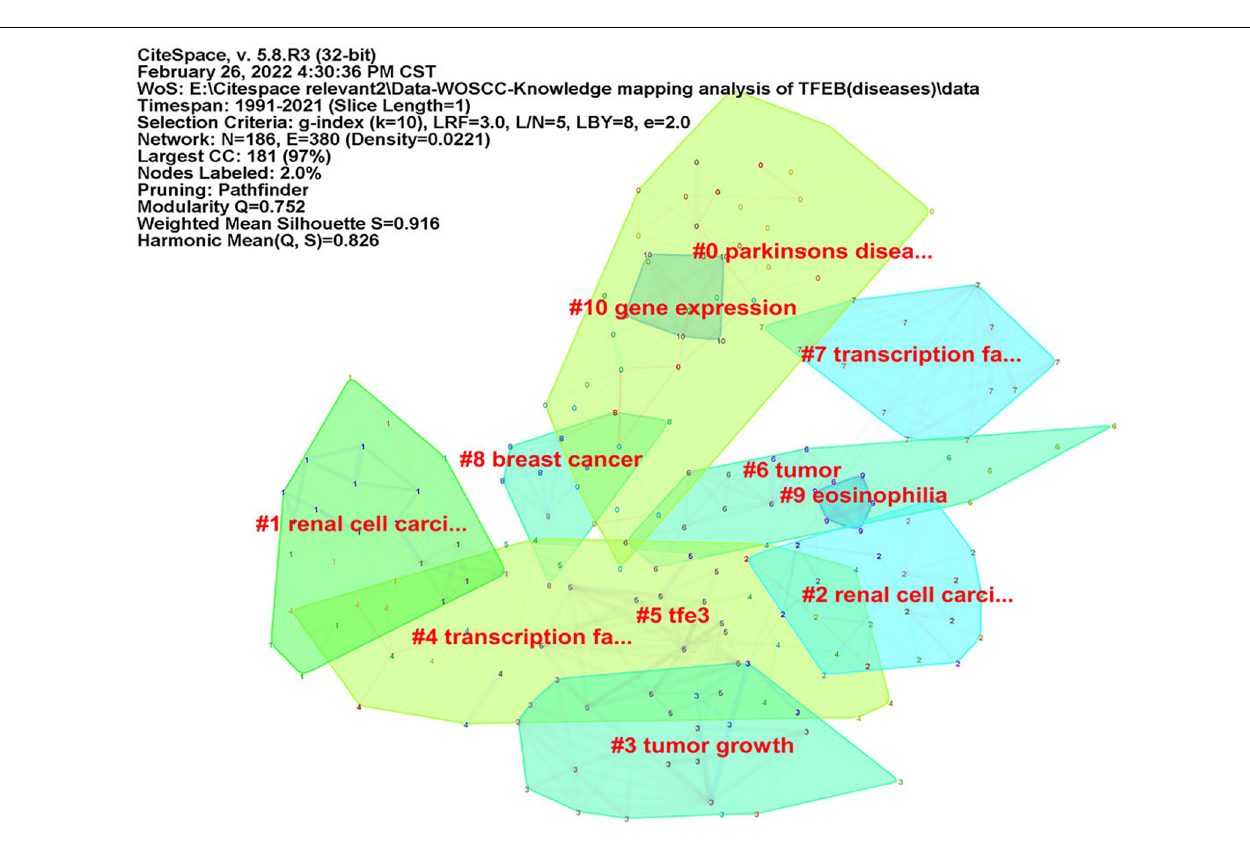
FIGURE 5 | Keyword clusters map of TFEB about